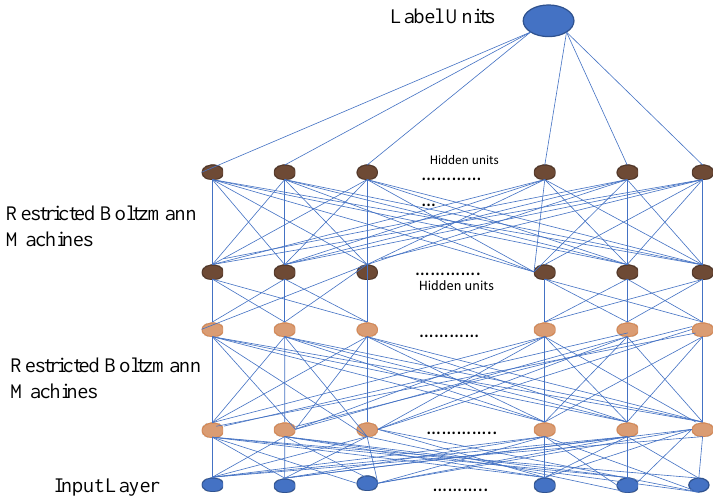
Figure 4. Simple deep belief network architecture.